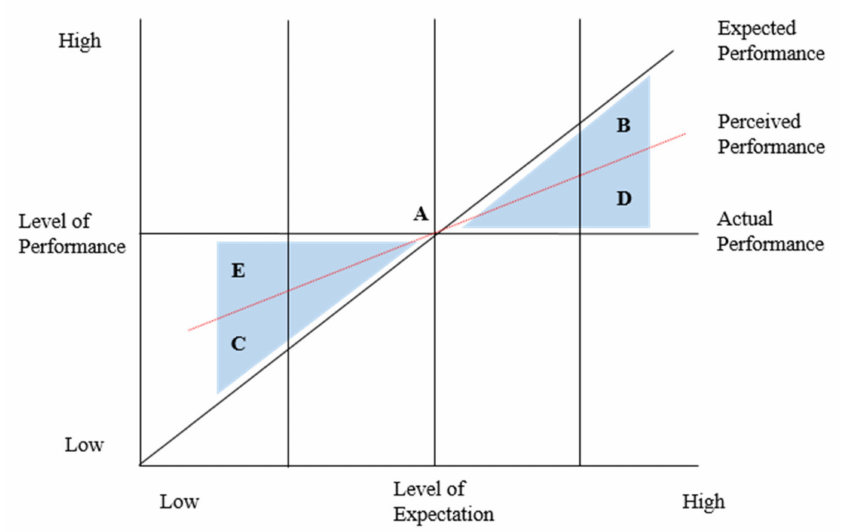
Figure 3. Schematic of the expectancy disconfirmation